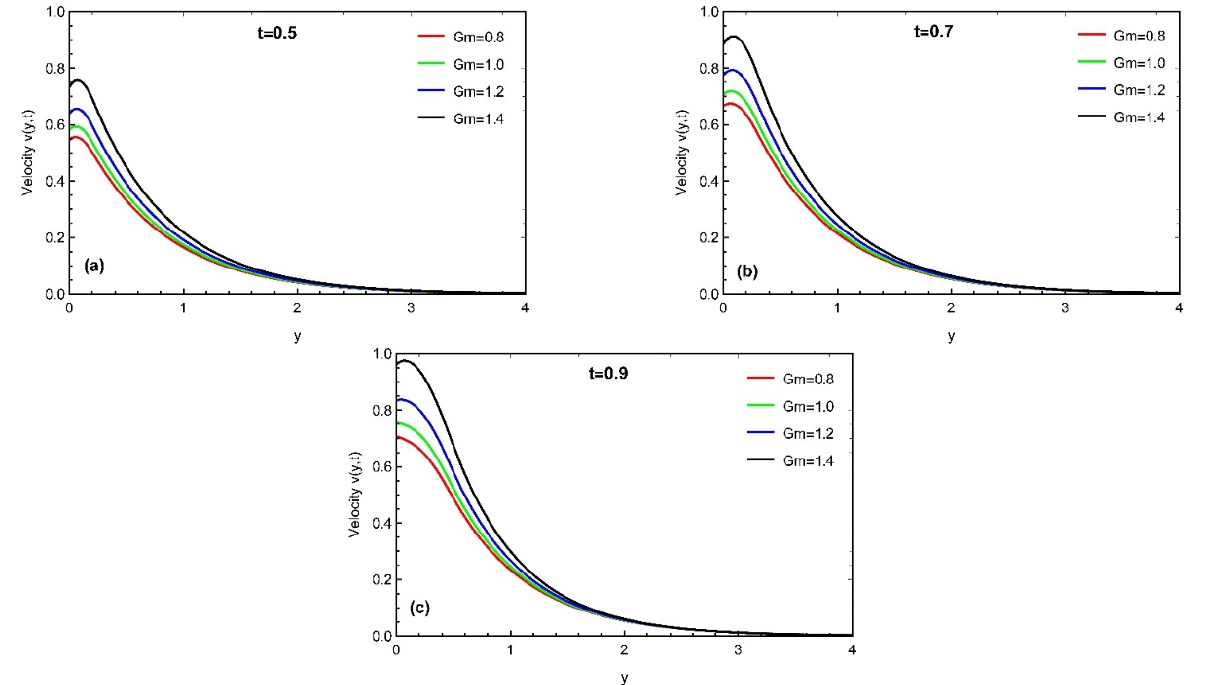
Figure 9. Variation in momentum field due to mass Grashof number with α = β = γ = 0.7, Pr ef f = 1.4, Sc ef f = 1.1, M = 1.75, Gr = 0.75, Re = 1.3, θ 1 = θ 2 = π ( a ) t = 0.5 ( b ) t = 0.7 ( c ) t = 0.9.